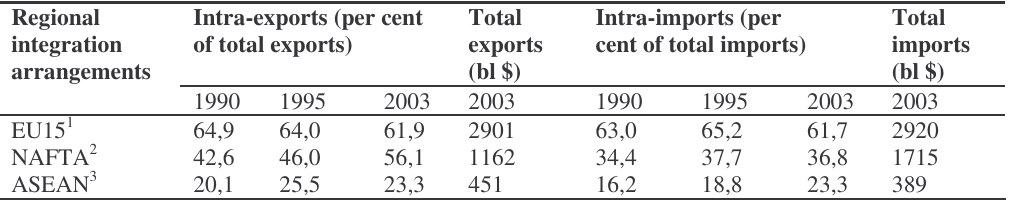
Total imports (bl $)